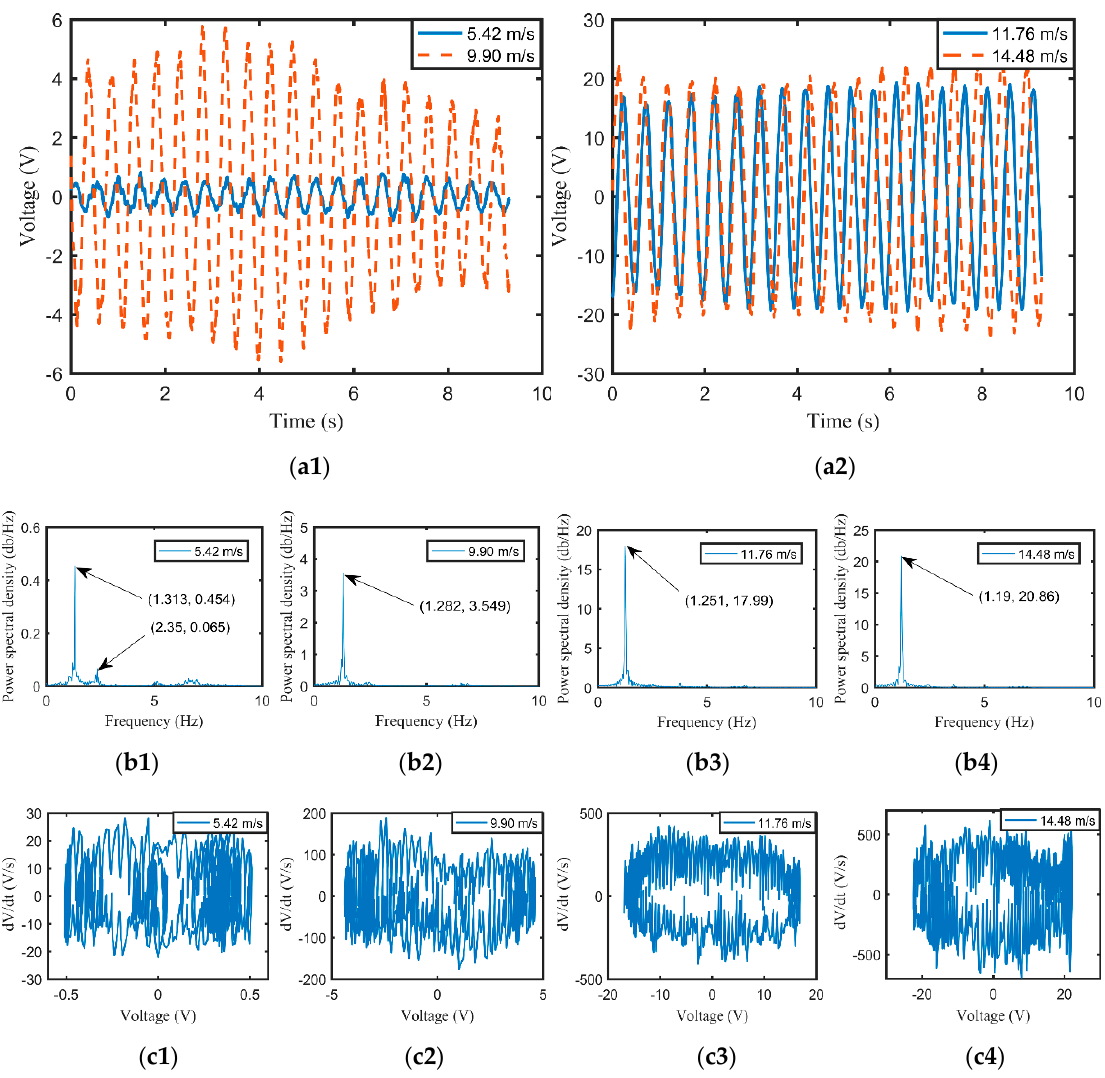
Figure 3. Time history, power spectral density, and phase portrait of output voltage for FSEH-130-20 at 5.42, 9.90, 11.76, and 14.48 m/s: ( a ) time history; ( b ) power spectral density; and ( c ) phase portrait.